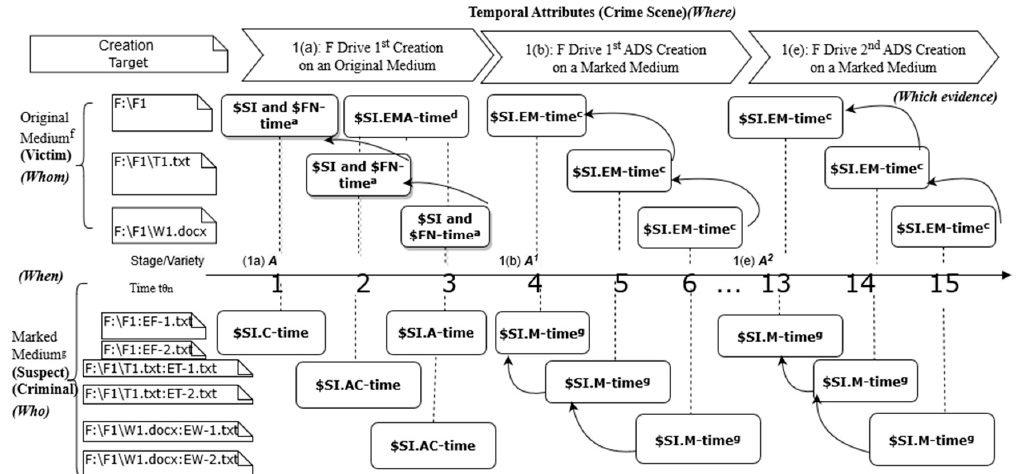
Figure 2. Temporal reconstruction on creation timeline (Stage 1). Note: a Rule 1, c Rule 3, d Rule 4, f Rule 6, and g Rule 7.